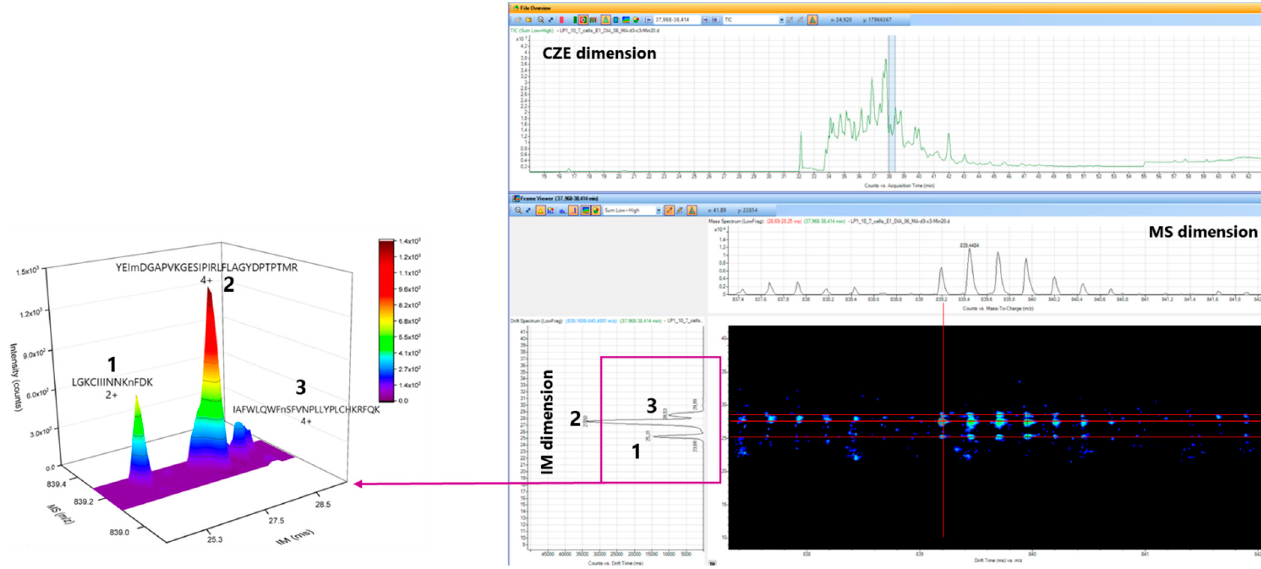
Figure 7. Example of three co-migrating and co-isolated peptides in CZE and MS dimensions. The separation of the three species was obtained in the IMS dimension allowing their identification.